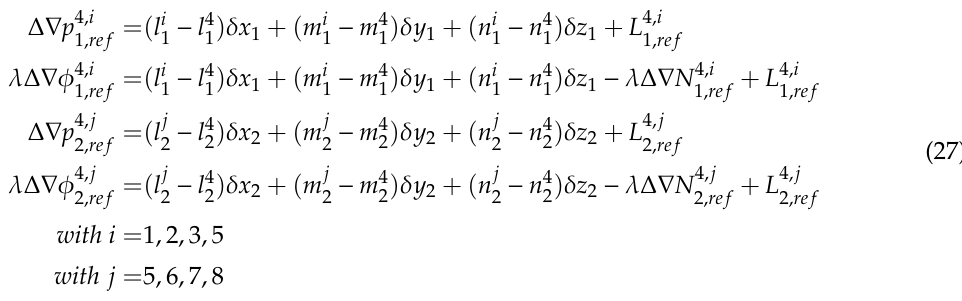
Figure 3. GNSS information and constraints for joint Real Time Kinematic (RTK) for connected vehicles. Supposing that the satellite 4 is our reference satellite, and the DD pseudo range and carrier phase observation equations in the e -frame are formed